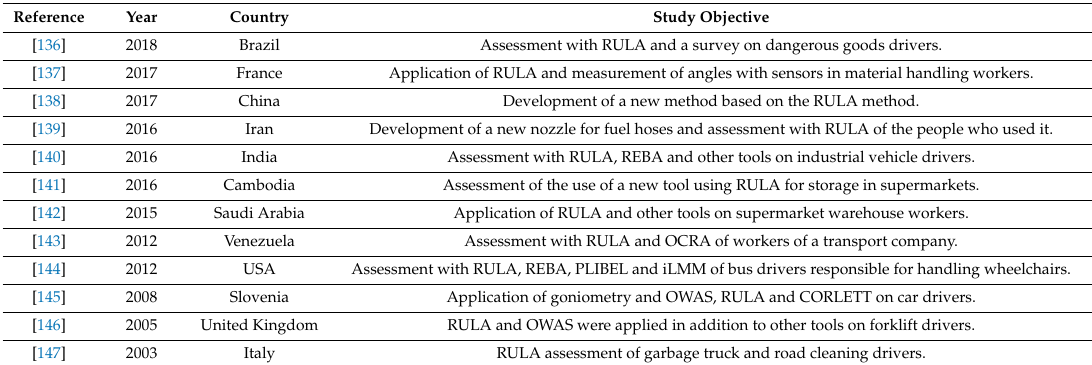
Table 9. Transportation and